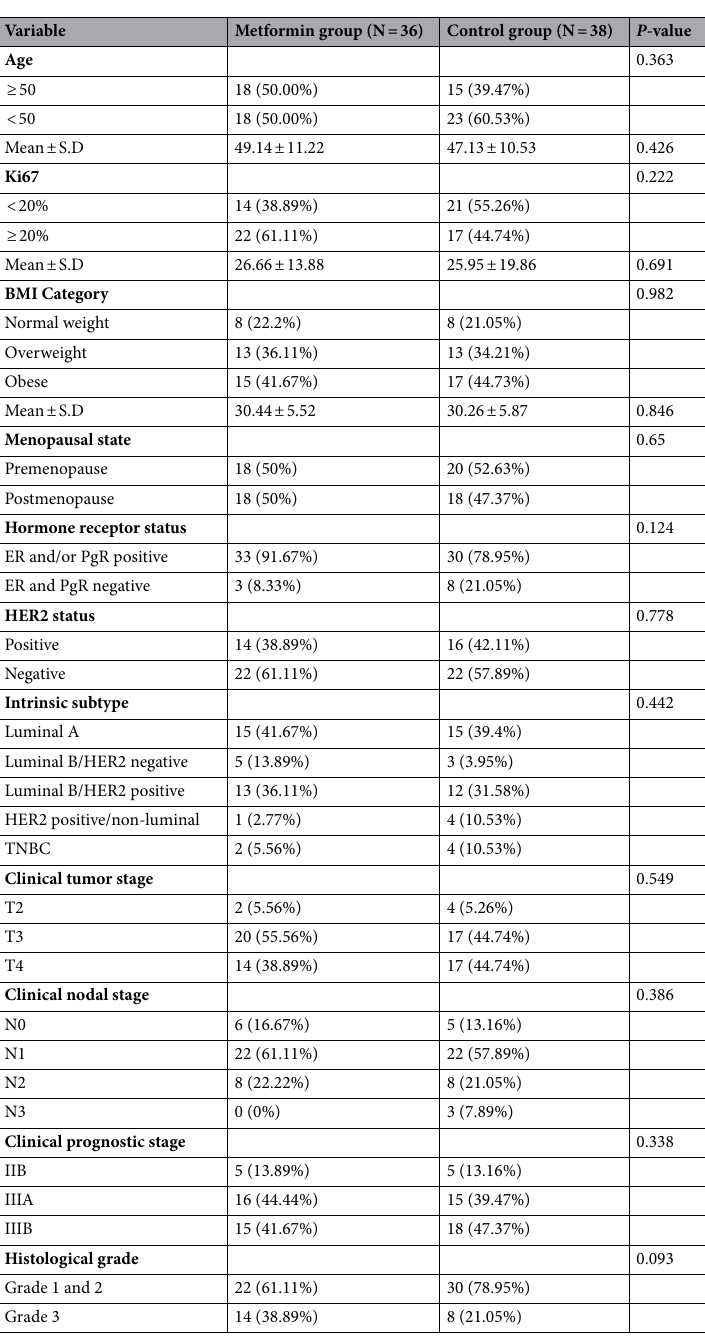
Table 1. Baseline patient demographic and tumor characteristics by study group. Ki67 proliferation index, BMI body mass index, ER estrogen receptor, PgR progesterone receptor, HER2 human epidermal growth factor receptor 2, TNBC triple negative breast cancer, SD standard